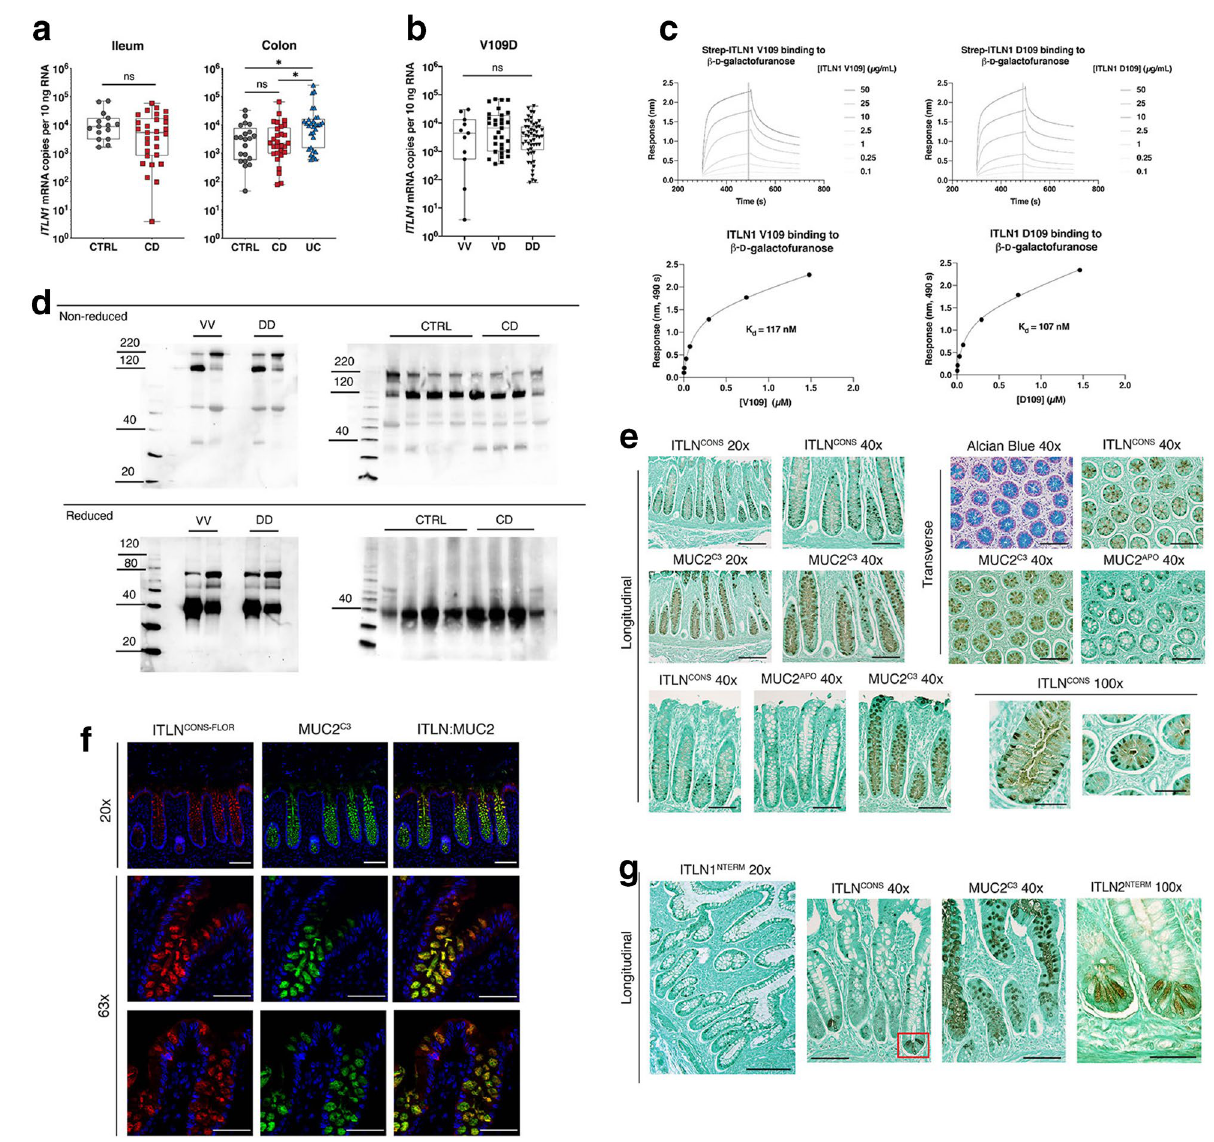
Figure 2. ITLN1 mRNA and protein expression in the small intestine and colon. ( a ) ITLN1 mRNA expression in surgical specimens of ileum and colon according to diagnosis. The mRNA copy number per 10 ng total RNA was determined with quantitative real-time RT-PCR using external cDNA standards (see methods). ( b ) ITLN1 mRNA expression by V109D genotype (excluding ulcerative colitis samples). Box plots present the median and first and third quartiles, whiskers present the range. Statistical analysis of ITLN1 mRNA expression was performed using either a Kruskal–Wallis test with Dunn’s multiple comparisons or two-tailed Mann–Whitney U test; * p < 0.05. ( c ) Representative real-time bio-layer interferometry responses of recombinant ITLN1 V109 and D109 binding to immobilized β-D-galactofuranose (upper). Responses at 490 s were plotted against ITLN1concentration and fit to a single site binding equation to determine Kd (lower). Data is representative of three separate experiments. ( d ) SDS-PAGE (4–20% gradient) immunoblots of human ileum by V109D genotype (left, n = 2 per genotype) and disease state (right). ( e ) Immunohistochemistry of human colon using the following antibodies: ITLN conserved (ITLN CONS ), ITLN1-specific (ITLN1 NTERM ), MUC2 mature (MUC2 C3 ), deglycosylated MUC2 (MUC2 APO , PH1900). Tissue counterstained by DAPI (blue). ( f ) Immunofluorescence of human colon using ITLN CONS-FLOR (anti-chicken; Alexa Flour 647) and MUC2 C3 (anti-rabbit; Alexa Flour 488). ( g ) Immunohistochemistry of human ileum; ITLN2-specific (ITLN2 NTERM ) antibody. Red box indicates Paneth cells identified with the ITLN CONS antibody. CTRL = control (non-Crohn’s disease and non-ulcerative colitis), CD = Crohn’s disease, UC = ulcerative colitis. Images in ( e – g ) are representative of multiple (> 6 fields) from 9 specimens. Light microscopy scale bars: 20x (200 µm), 40x (100 µm), and 100x (50 µm); fluorescence microscopy scale bars: 20x (100 µm) and 63x (50